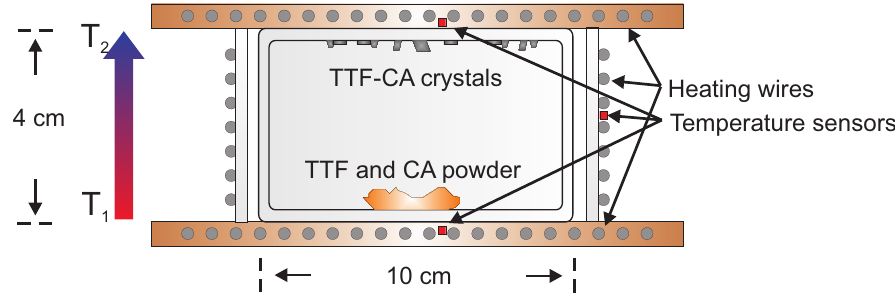
Figure 6. Schematic setup of the plate sublimation. It consists of two copper plates with incorporated meander-like thermocoax wires. A PT-1000 temperature sensor (red square) is placed in the center of each plate to check their temperature. The so-called French cheese box is located between the two plates and is surrounded by a glass ring. A third thermocoax wire is helically glued on the ring with Stycast. The temperature is controlled by a third PT-1000 in the center of the ring as well. During the growth process, a temperature gradient is set to about ∆ T = T 2 − T 1 between the two plates. The starting powder material is placed on the bottom of the glass box. The TTF-CA crystals grow on the colder top part of the glass